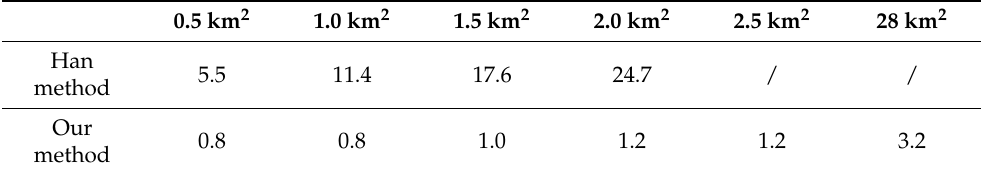
Table 7. Comparison of the memory consumed using the two methods for hole filling in different experimental areas.